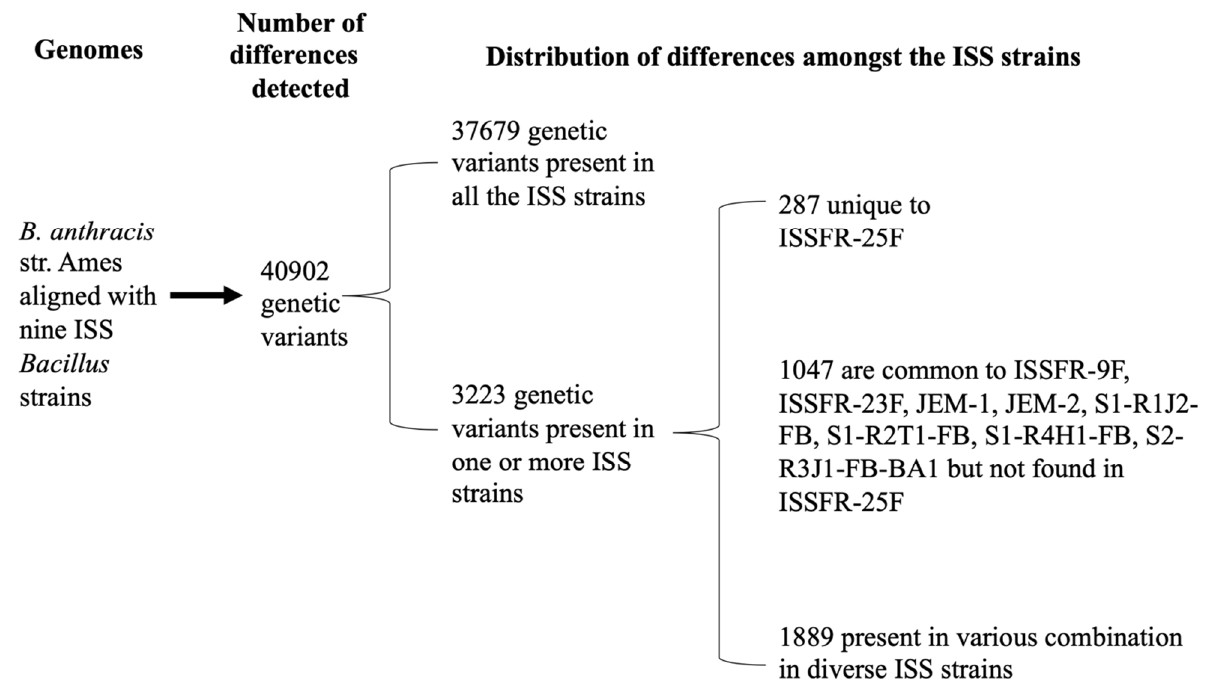
Figure 4. Number of genetic variants (point mutations, recombinations and/or deletions) between whole genomes of ISS Bacillus isolates (ISSFR-9F, ISSFR-23F, ISSFR-25F, JEM-1, JEM-2, S1-R1J2-FB, S1-R2T1-FB, S1-R4H1-FB, S2-R3J1-FB-BA1) and B. anthracis str. Ames. Unique genetic variants of the ISS Bacillus isolates, with a predicted high impact on protein product, are reported in Supplementary Table S1.